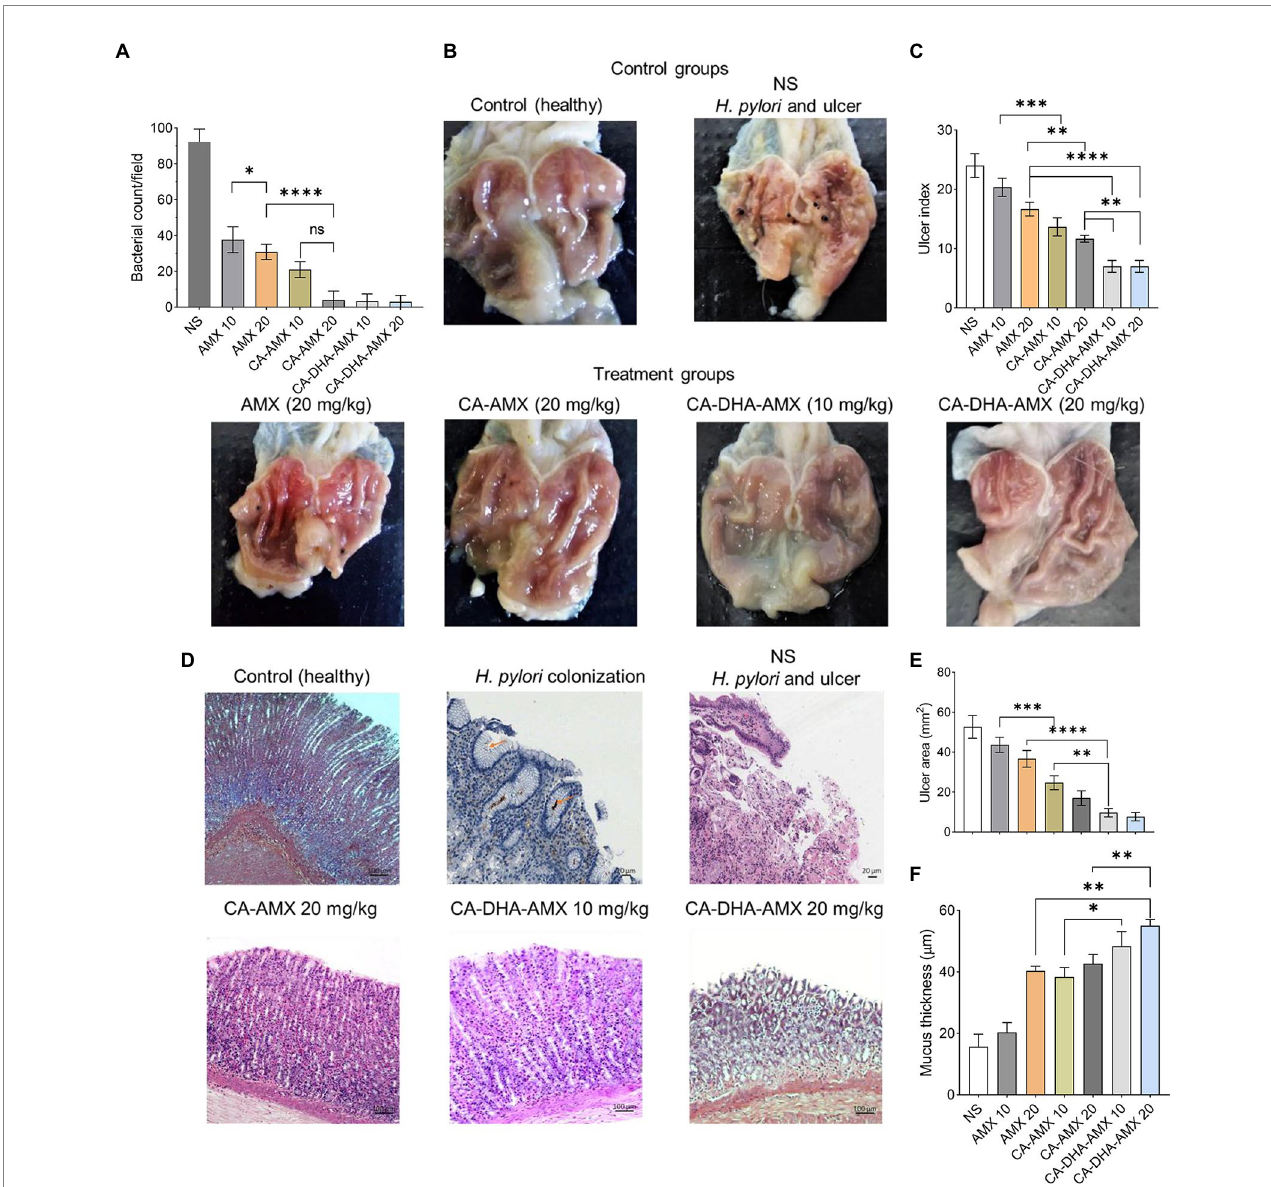
FIGURE 6 A histopathological evaluation of ASA-induced ulcers in rats infected with H. pylori . (A) The bacterial count of biopsies in treatment groups at day 14. (B) The phenotypic assessment of the rat stomach in different examined groups at day 14. (C–F) The analysis of ulcer index, histopathological features, ulcer area, and mucosa thickness of treated groups compared with control (untreated group). Data are presented as mean ± SEM ( n =